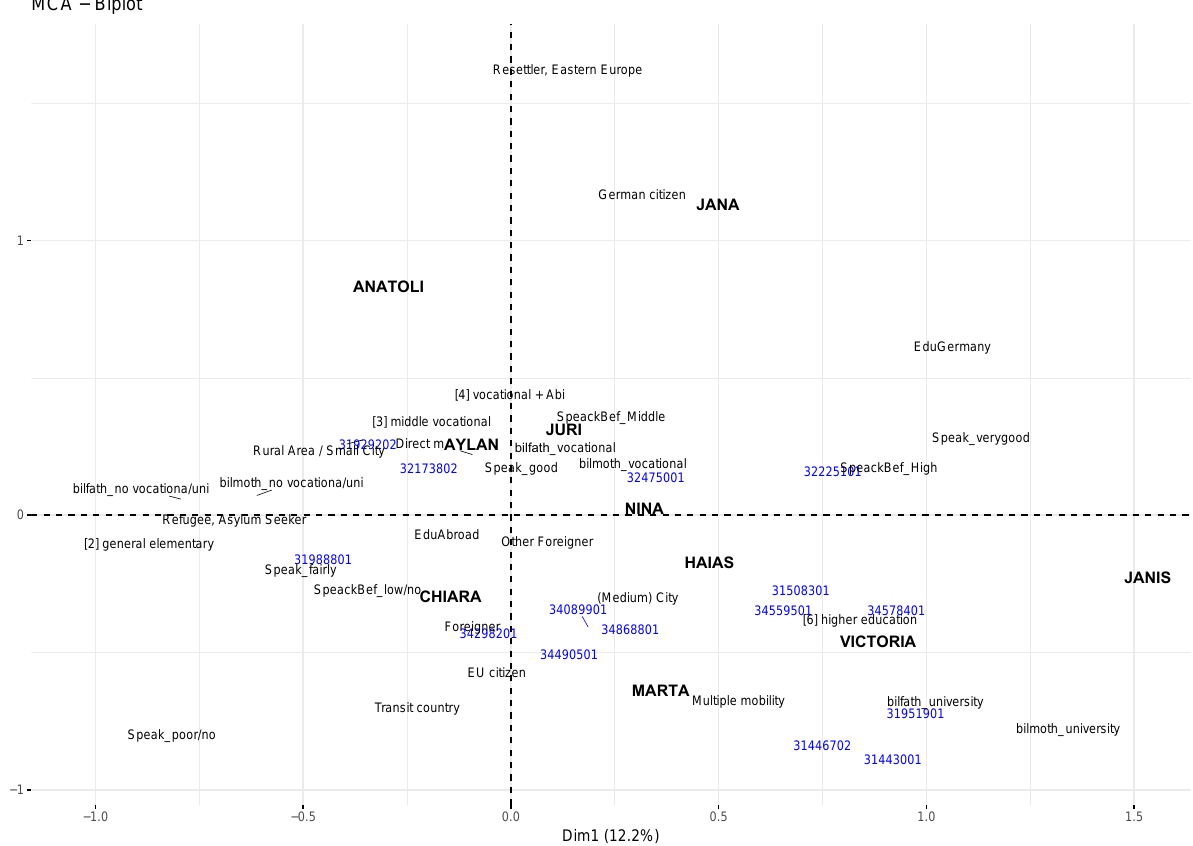
Figure 4. Positions of the 26 SOEP respondents. Source: SOEP (2019, survey year